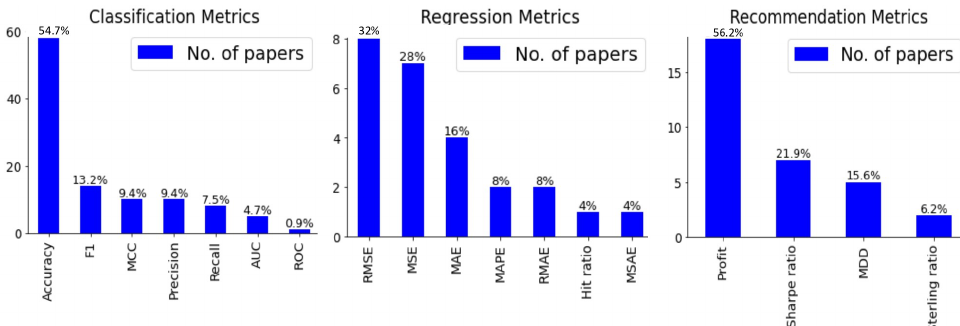
Figure 8. Distribution of evaluation